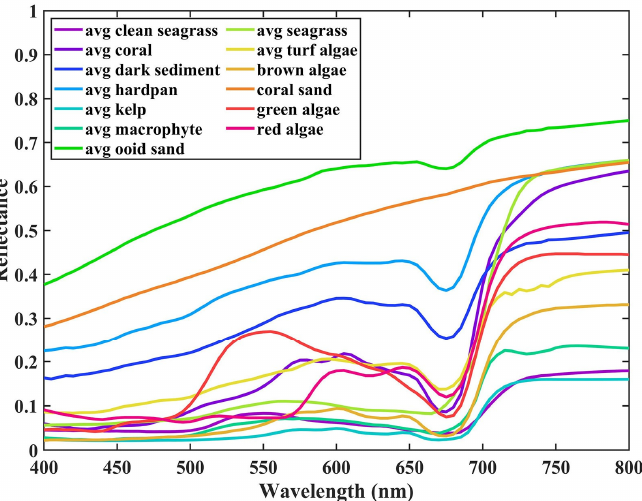
Figure 1. Bottom reflectance of various sediments provided by HE5, covering from 400 nm to 800 nm.